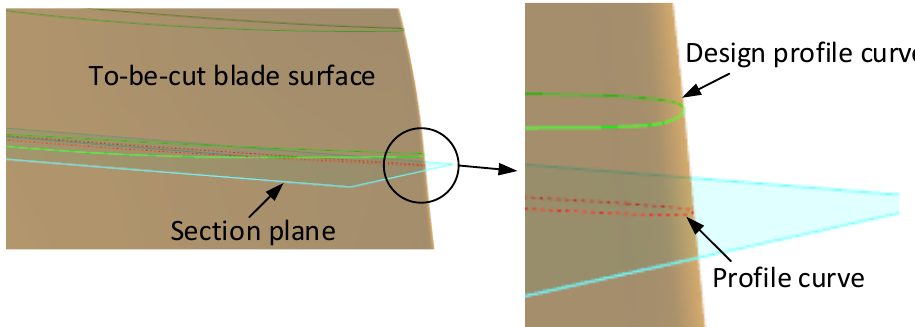
Figure 6. Profile curves calculation between the section plane and the to-be-cut blade surface. The parametric equation of the blade surface is